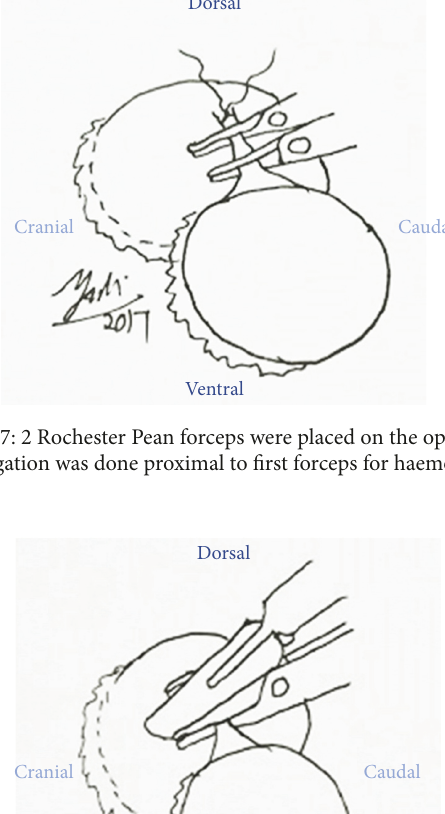
Figure 4: Maintenance of surgical plane was achieved by con- tinuously flushing marine water that contains 17ppm isoeugenol through spiracle by using a 20 mL syringe.